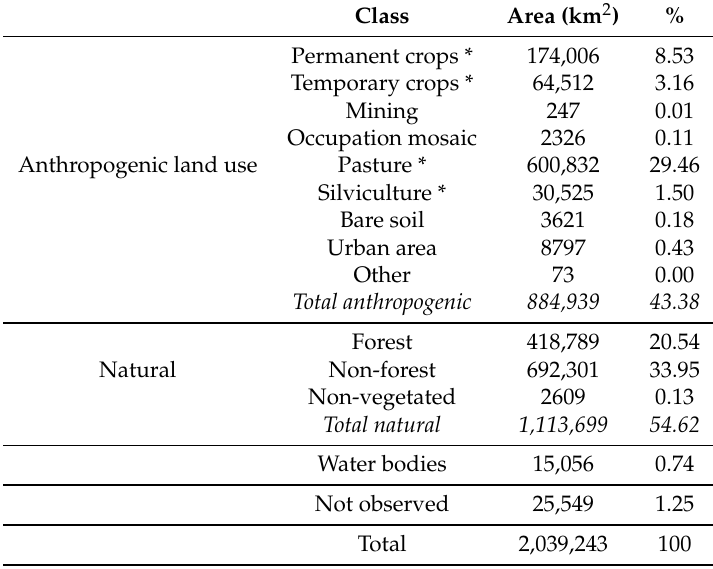
Table 1. Area of each land use and land cover classes in the Cerrado